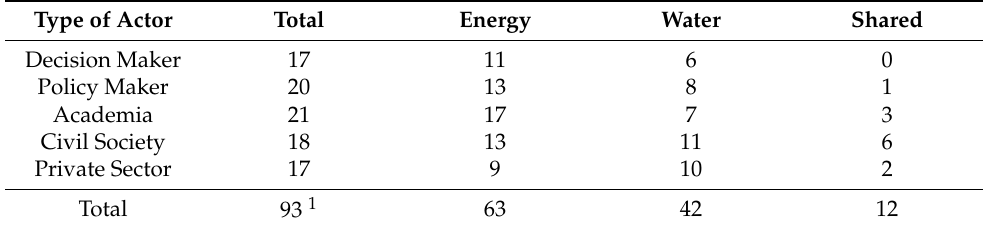
Table 1. Distribution of interviewees by type of actor. Type of Actor Total Energy